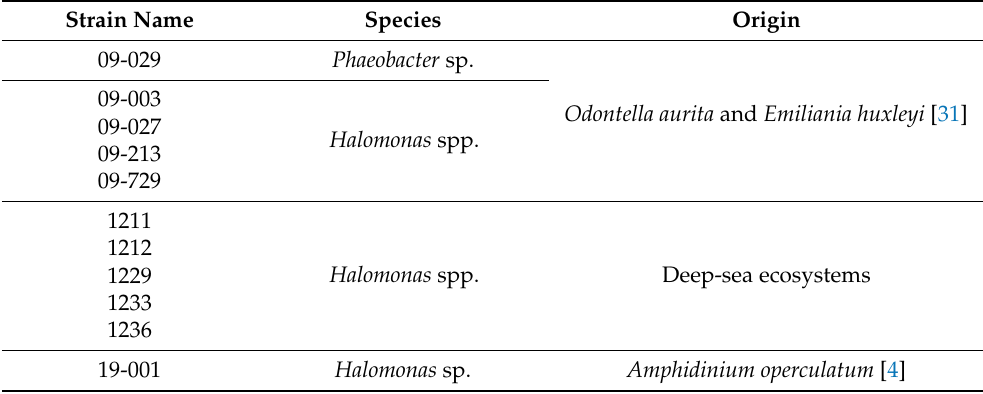
Table 1. Origin of the bacterial strains